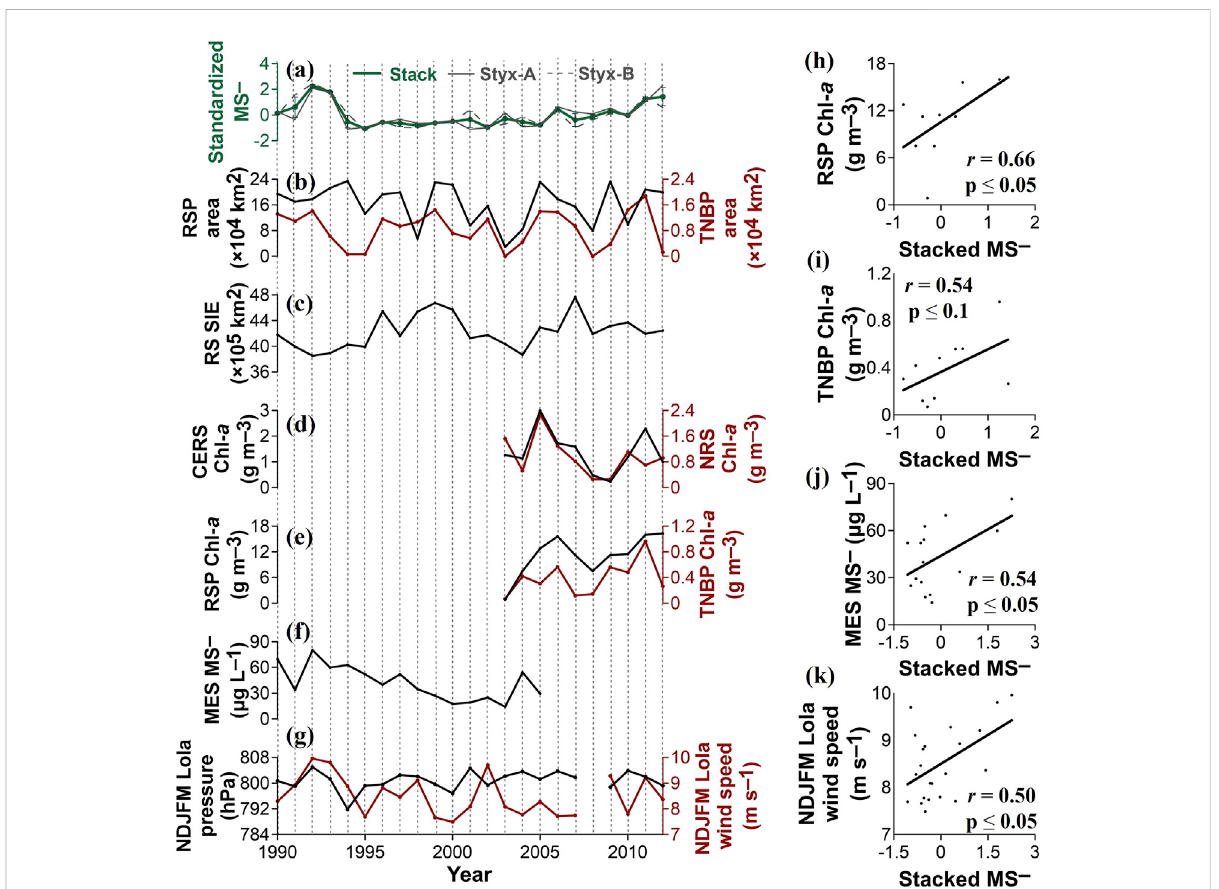
FIGURE 5 (A) Stacked record of annually averaged MS – concentrations in the Styx-A and -B cores. The stacked pro fi le was produced after standardizing the observed MS – concentration data (see text). The vertical bars represent the standard error for each annual value. (B) Satellite-derived NDJFM open water areas in the RSP and the TNBP (see Supplementary Section S1), (C) maximum SIE in the Ross Sea (RS) sector, (D) NDJFM chlorophyll